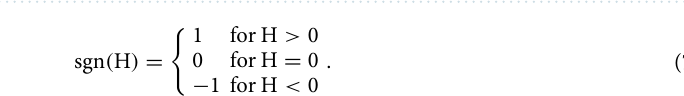
Figure 4. Simulated and measured data in time and frequency domain. ( a ) Simulated signal of a delta sample performing uniform linear motion in time and frequency domain for different sample velocities: { 0, 0.75, 1.5 } m/s. The simulation parameters were set to: f D = 1 kHz, x max FFP = 12 mm, G = 1 T/m, m 0 = 3.35 · 10 − 18 Am 2 . The higher harmonics in frequency space split up into two peaks for moving particles. ( b ) Measured signal of the oscillating Perimag sample at the analog-to-digital converter (ADC) in time (top, center) and frequency space (bottom). The signal is shown exemplarily for an excitation frequency of 5 kHz and a quantified sample velocity of 2.07 m/s. In time domain, four field of view (FOV) crossings are shown (top) and a zoom into one FOV crossing is provided (middle). To obtain the signal in frequency space, the Fourier transform of the signal caused by only one FOV crossing is performed. The splitting of the higher harmonics due to the sample motion can be seen in the frequency spectrum, particularly at high harmonic